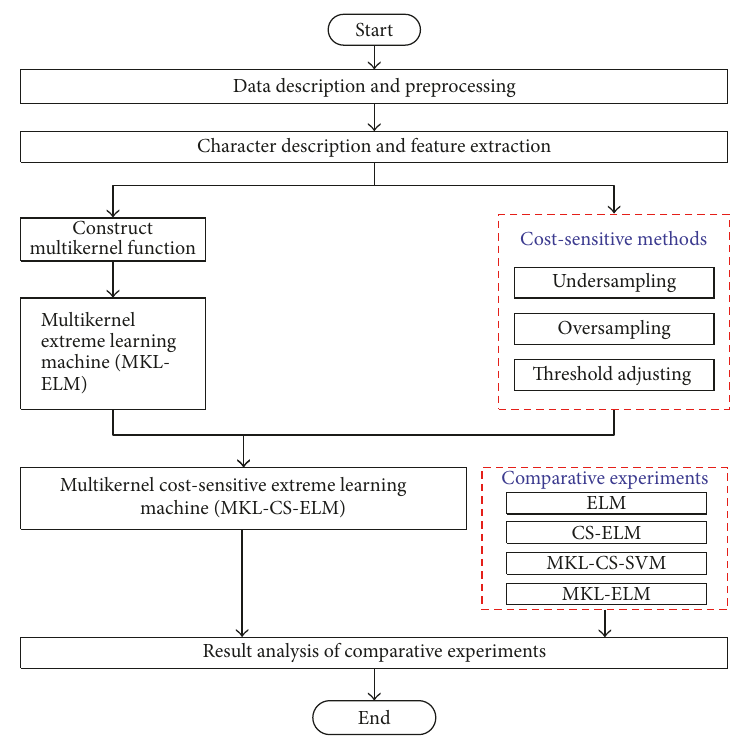
Figure 1: The realization process of MKL-CS-ELM.